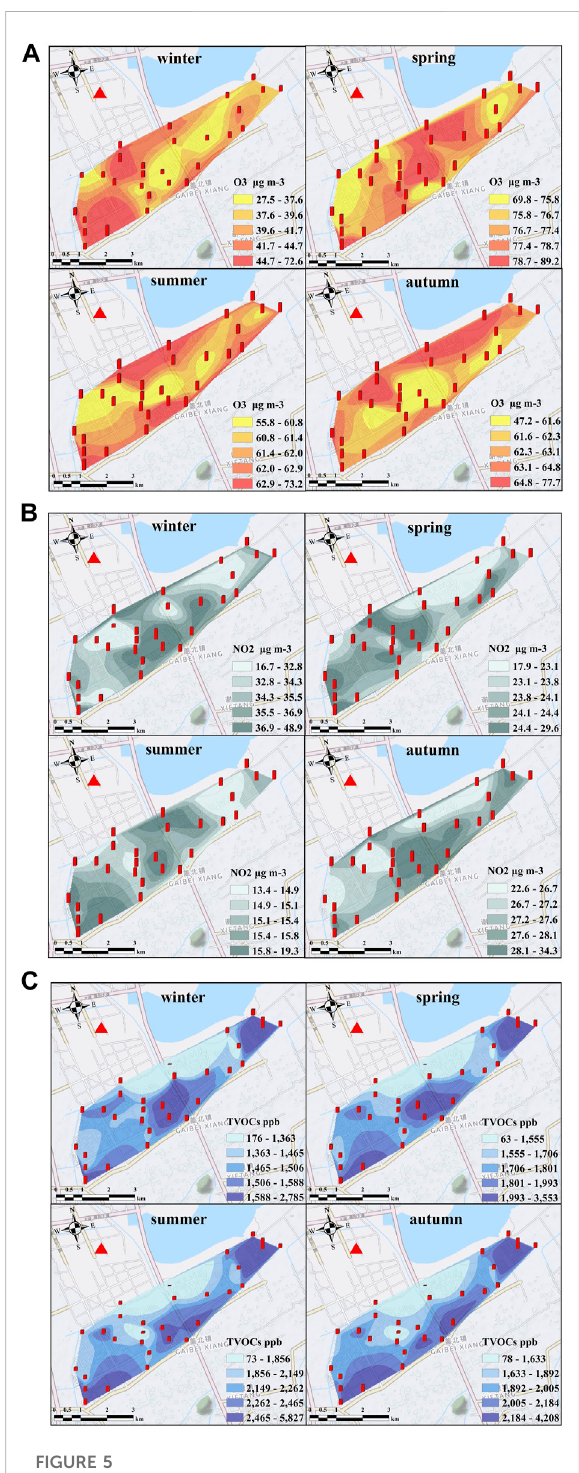
FIGURE 5 Spatial distribution of O 3 (A) , NO 2 (B) , and TVOCs (C) from December 2019 to November 2020, including 29 air monitoring stations in FCIP. One site is not included because it is located outside the FCIP (the red triangle represents that